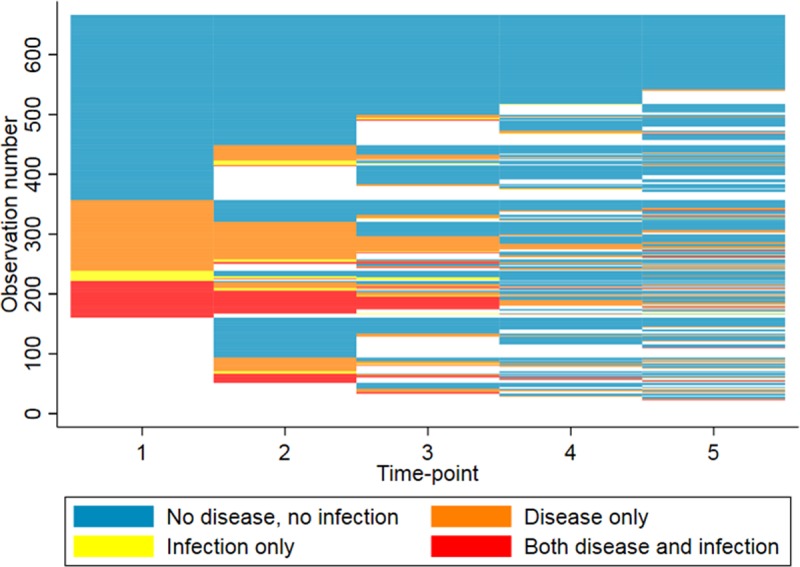
The clinical disease (Active Trachoma) and infection status of individuals at each time-point, ordered by status at baseline.Each row represents an individual and each column represents a time-point.